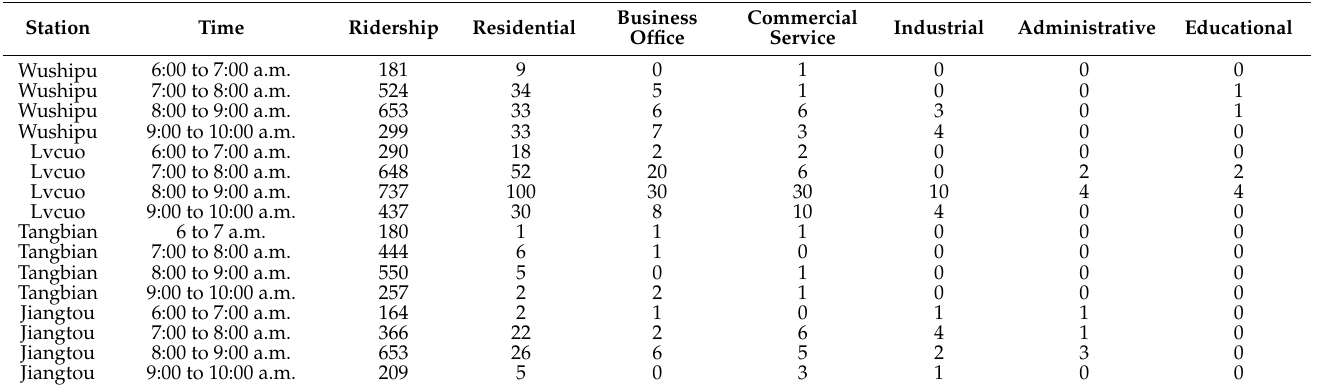
Table 3. Urban rail station ingress ridership distribution with land use pattern.